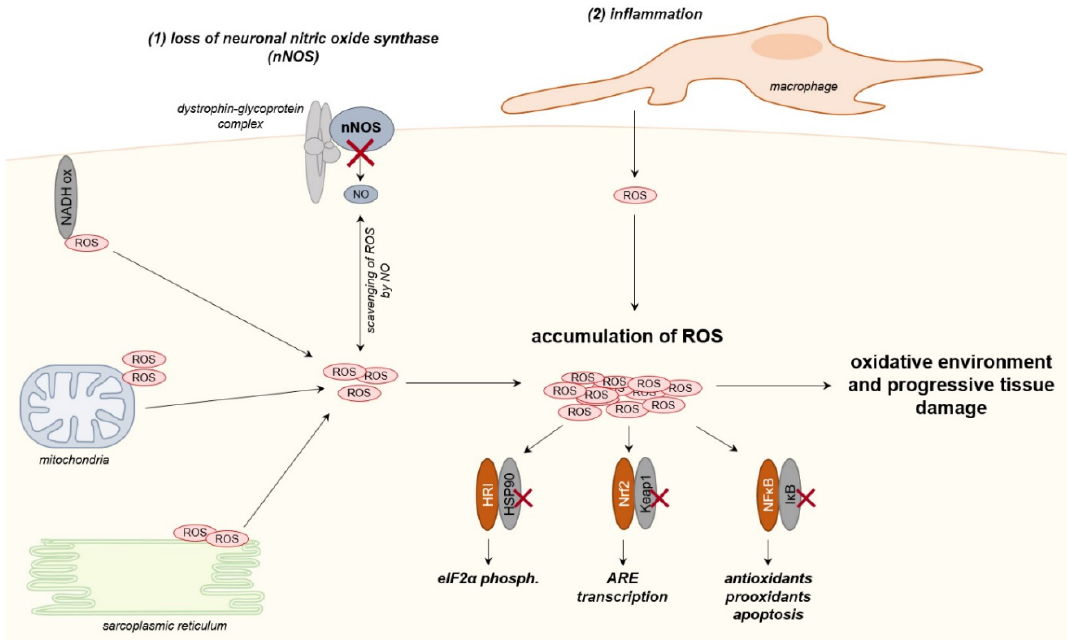
Figure 3. Oxidative stress in Duchenne muscular dystrophy (DMD). Due to the perturbation of the dystrophin-glycoprotein-complex, there is a loss of neuronal nitric oxide synthase (nNOS),